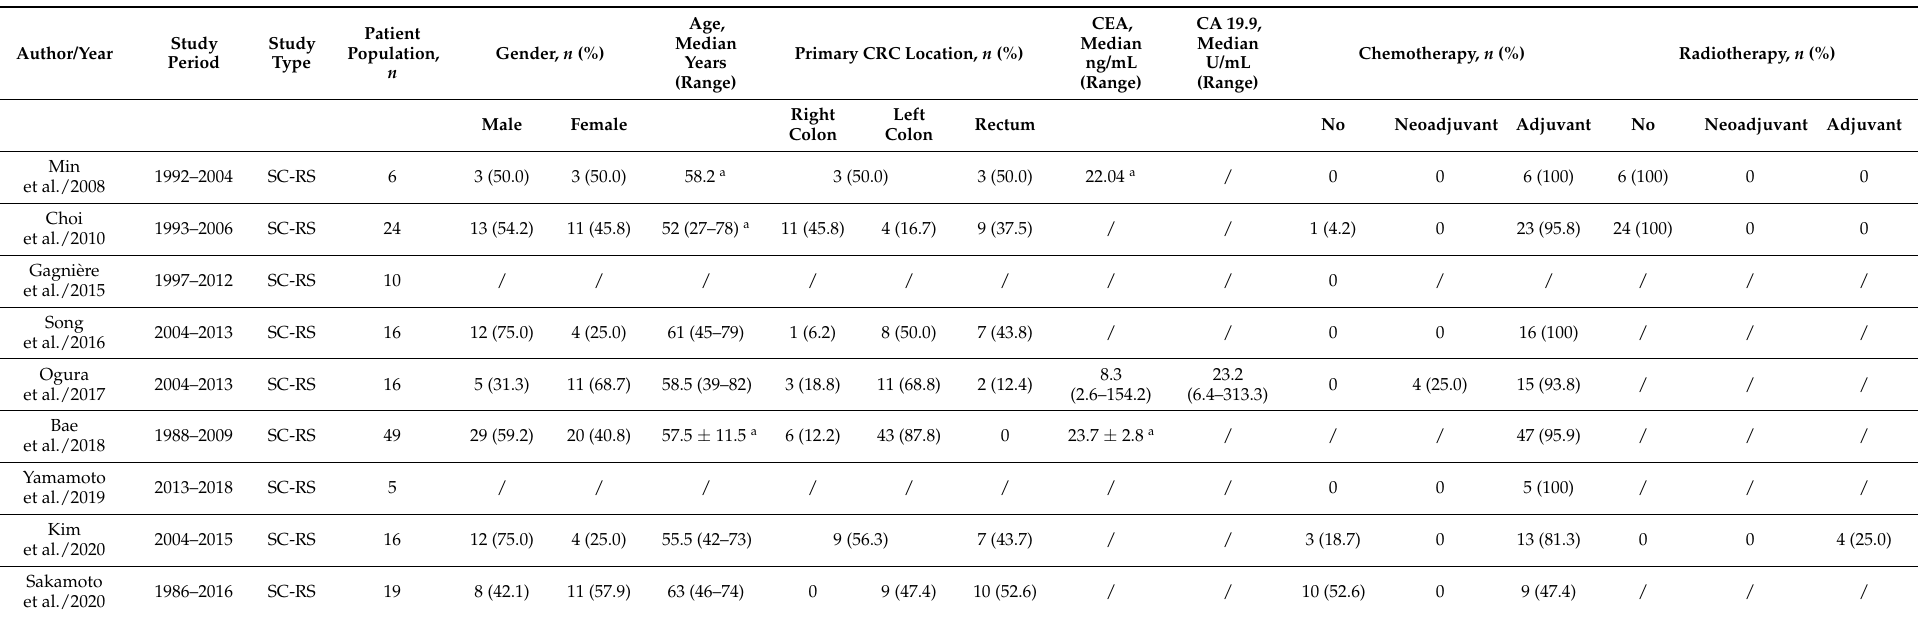
Table 1. General population characteristics.